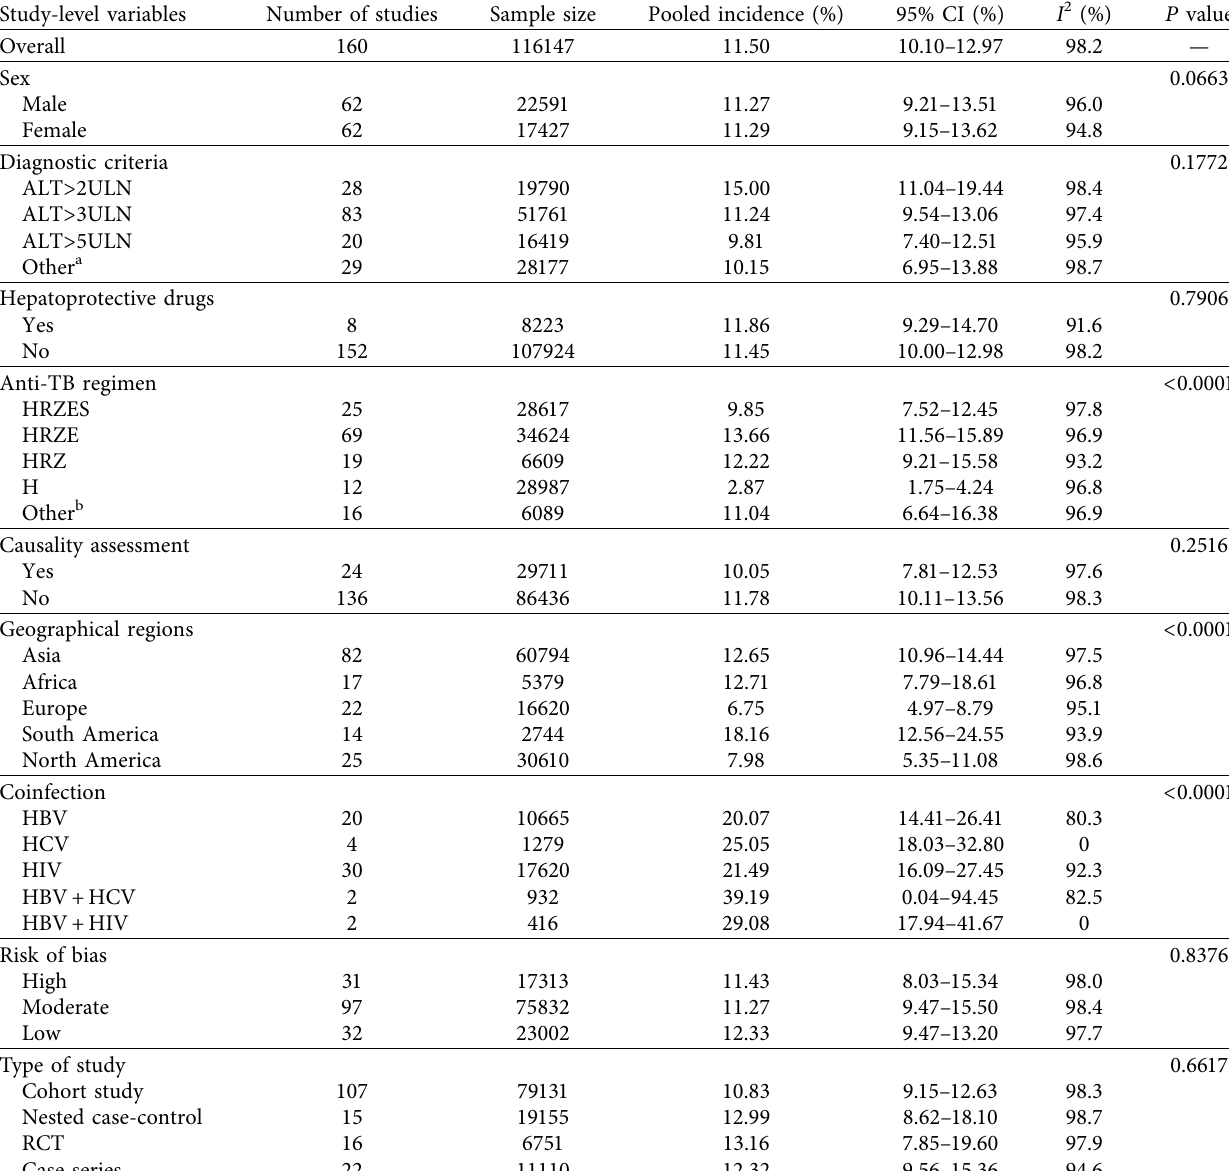
Table 1: The results of overall and subgroup analyses by different